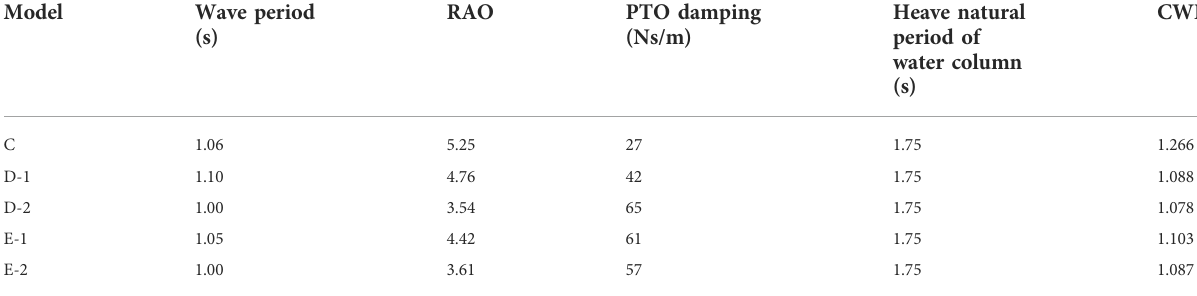
TABLE 6 Peak capture performance of these models with different bottom